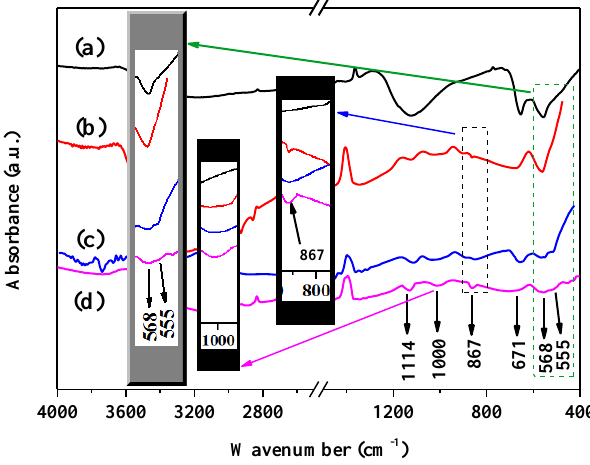
Figure 3. Fourier transform infrared spectrum (FT-IR) spectra of the ( a ) MoO 3 -doped MnCo 2 O 4 (0), ( b ) MoO 3 -doped MnCo 2 O 4 (0.04), ( c ) MoO 3 -doped MnCo 2 O 4 (0.10), and ( d ) MoO 3 -doped MnCo 2 O 4 (0.12).